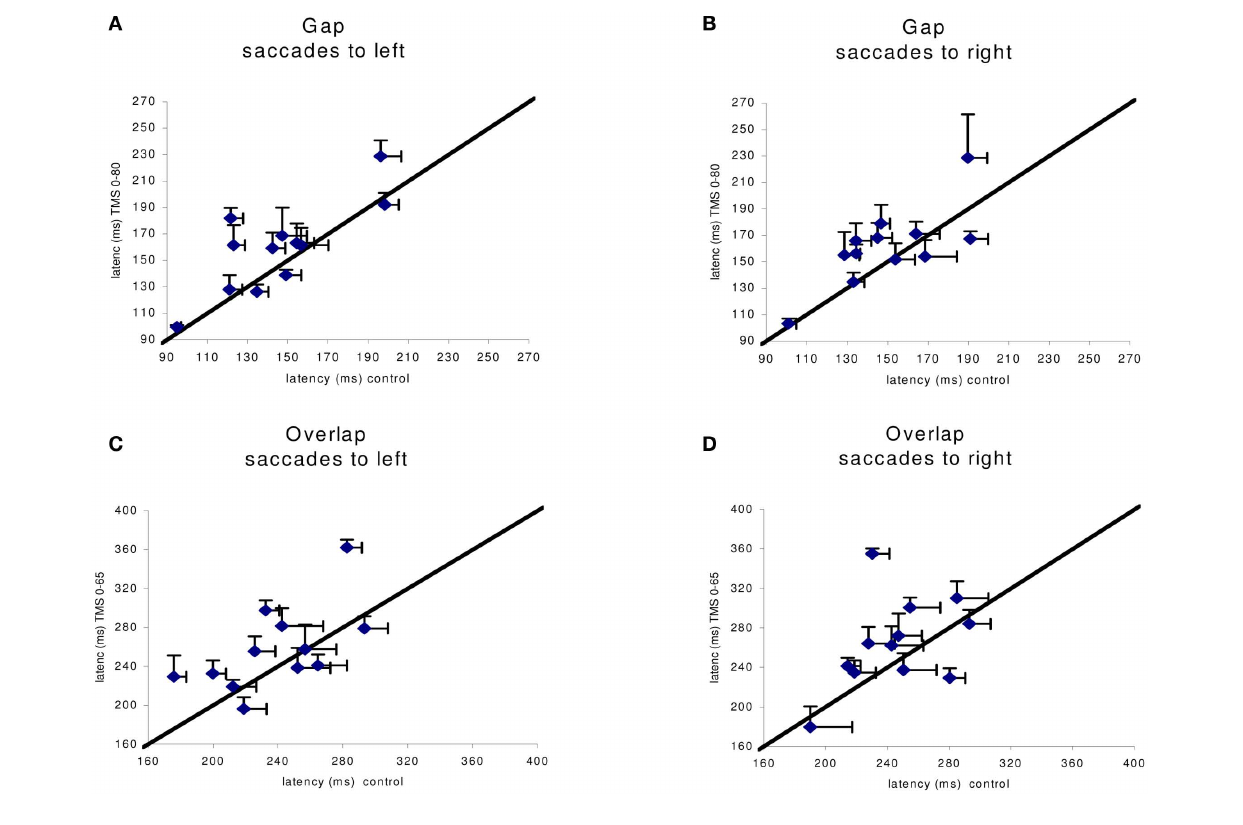
gap task in the control versus dTMS conditions, ISI 0–80ms; in (C,D) are shown data from the overlap condition in the control versus dTMS condition, ISI